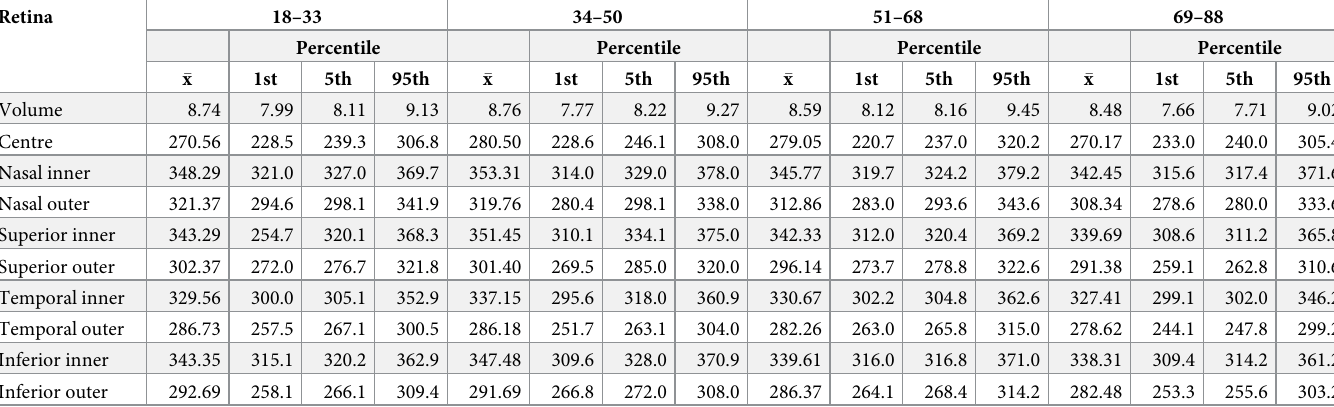
Table 4. Macular retinal thickness distribution by age group, showing mean, first, fifth and 95th percentile values for each segment.